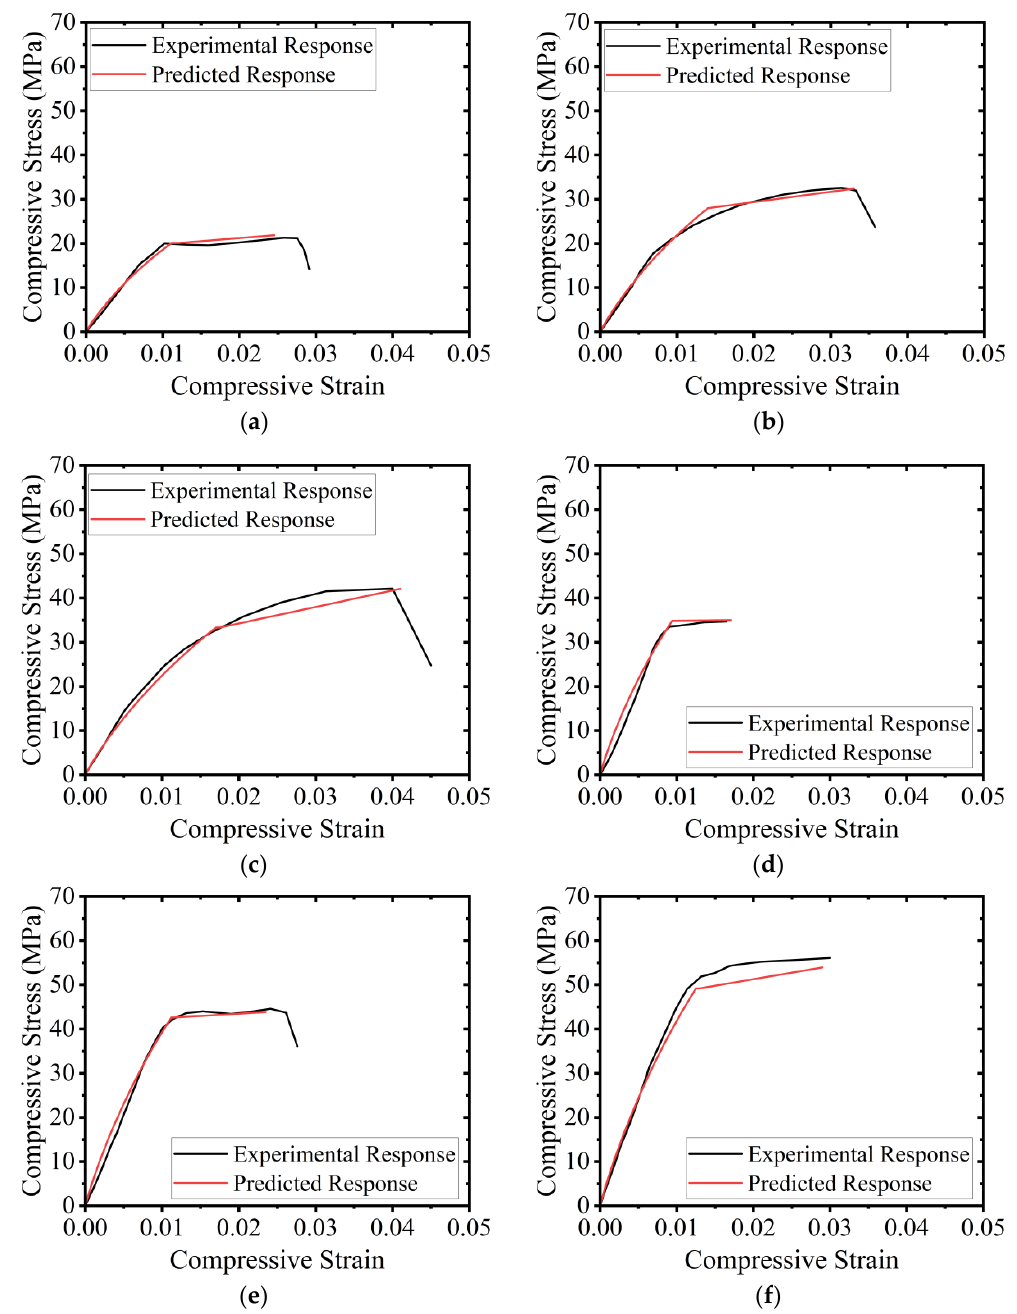
Figure 20. Comparison of experimental vs. predicted compressive stress – strain curves for hemp-